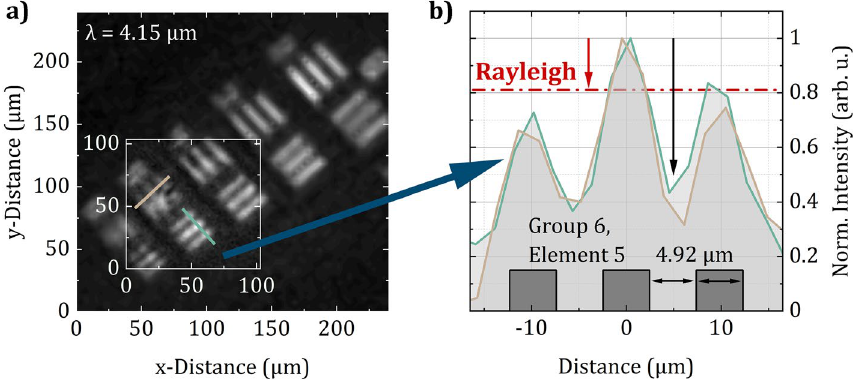
Figure 4. Spatial resolution of the MIR hyperspectral SPI microscope. ( a ) Collage of two 64 × 64 images of the elements 2–6 of group 6 of a USAF resolution test target acquired with super-pixels consisting of 7 × 7 and 3 × 3 2 2 micromirrors leading to FoVs of 240 × 240 µ m and 103 × 103 µ m , respectively. ( b ) Profiles of element 5 of group 6 of a USAF resolution test target acquired with the MIR SPI microscope verifying diffraction-limited spatial